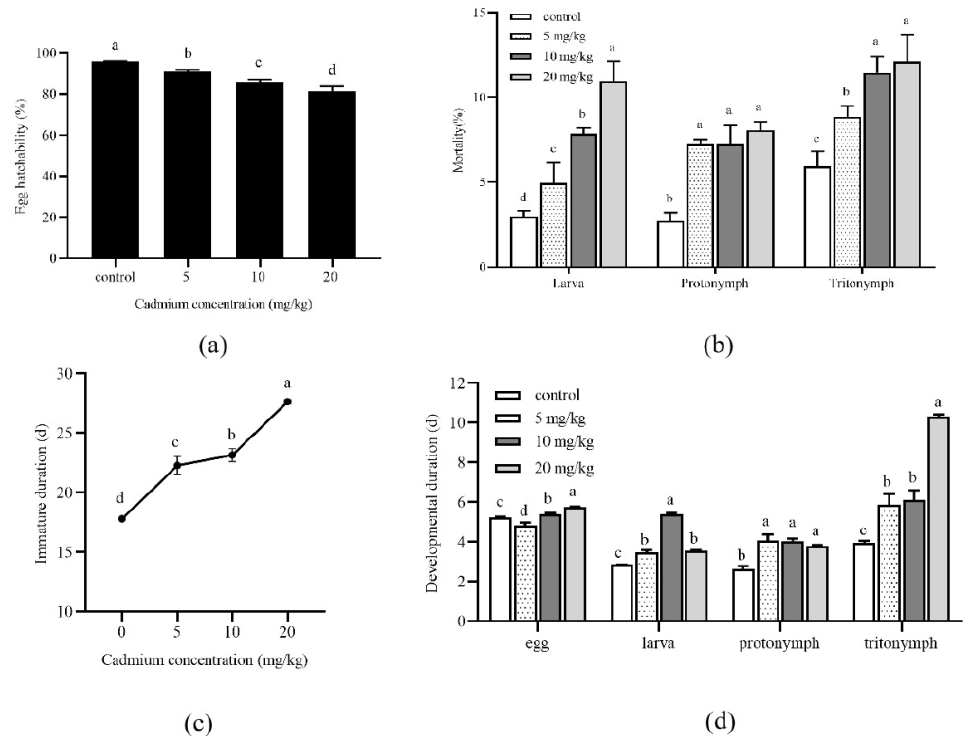
Figure 1. Effects of long-term cadmium exposure on the development of Aleuroglyphus ovatus. ( a ) Egg hatchability; ( b ) Mortality of different development stages; ( c ) Total immature development duration; ( d ) Development duration of major immature stages. Results are expressed as mean ± SD. Different lowercase letters indicate significant differences between treatments at different Cd concentrations ( p < 0.05).